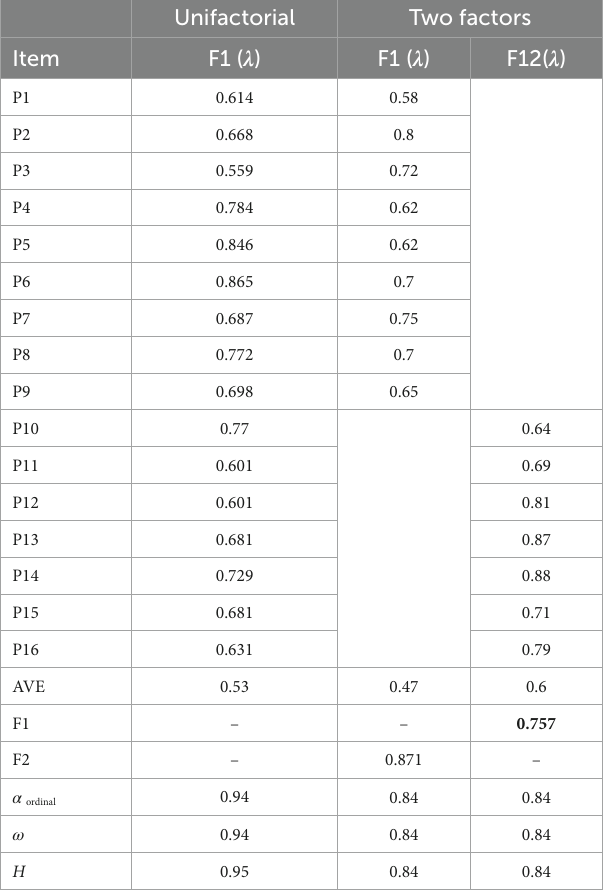
TABLE 4 Confirmatory Factor Analysis, one-factor model, two-factor model, and reliability.